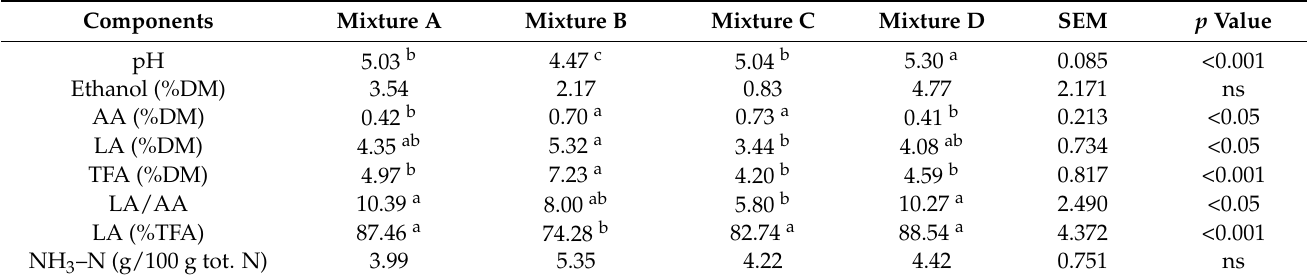
Table 3. Fermentation characteristics of ensiled mixtures at the end of 90 days fermentation ( n = 20).